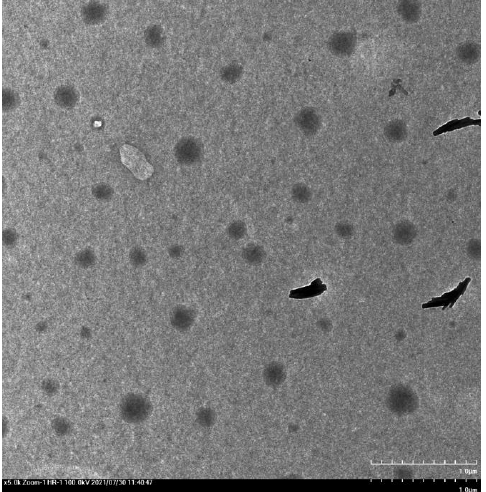
Figure 7. TEM image of DNC/GA/PVP K30 micelles .